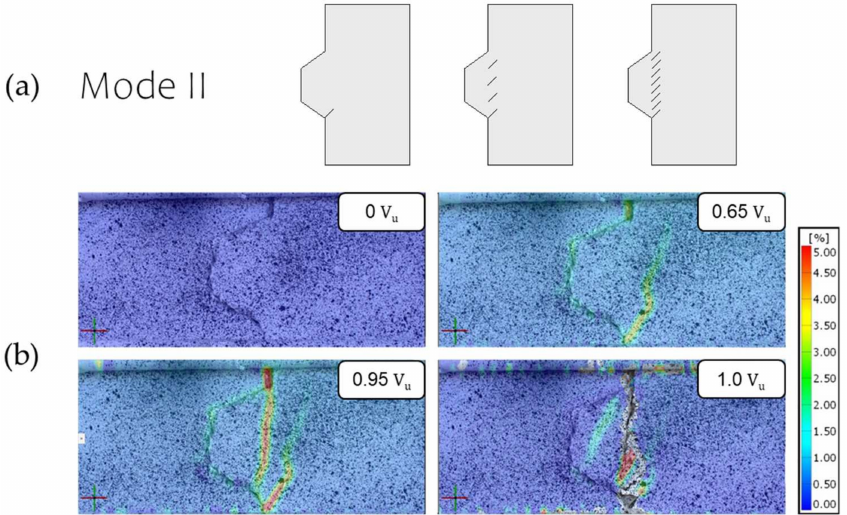
Figure 18. ( a ) Crack model 2 of the single-keyed dry joints of Jiang et al. [30] and ( b ) crack pattern of the specimen CPR1-1-1.0.